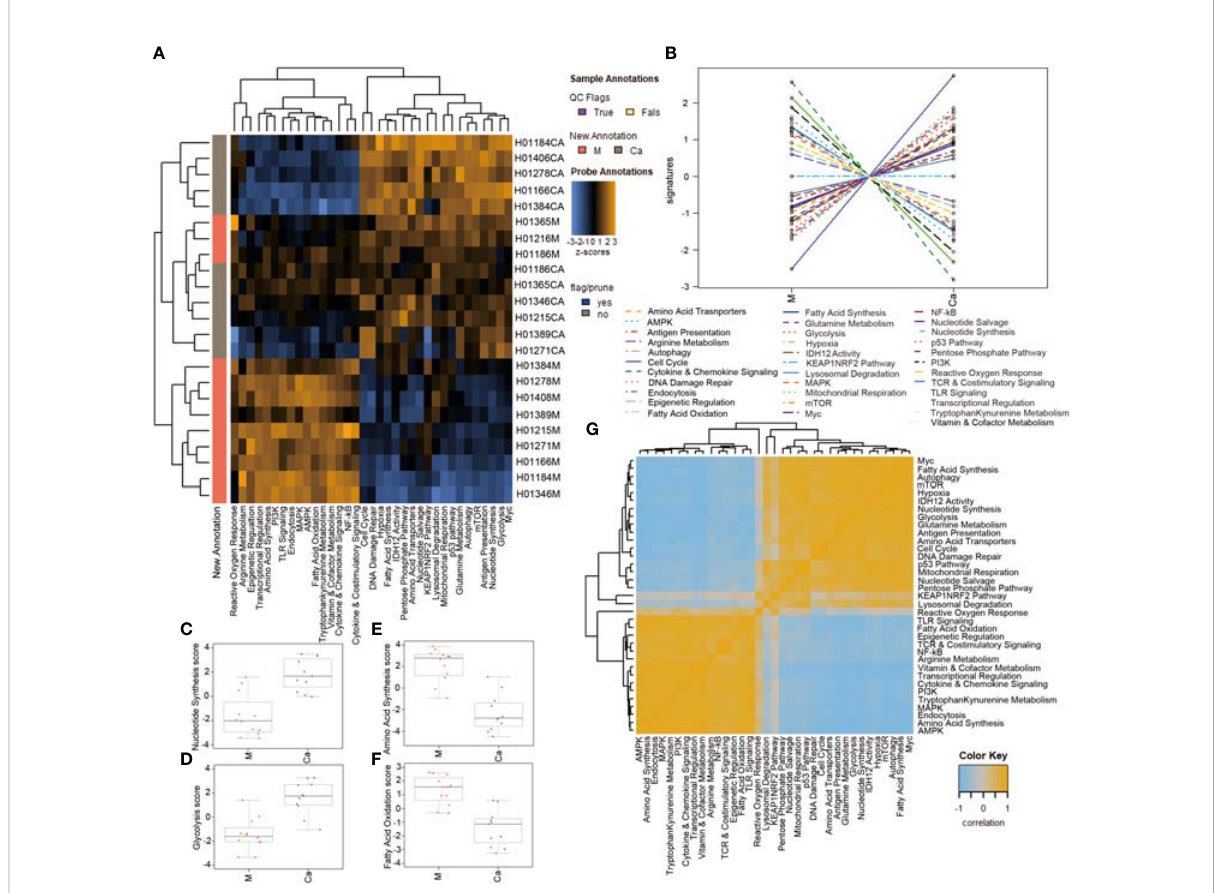
FIGURE 2 Analysis of differential signaling pathways in Metabolic Pathways Panel between HSCC tissues and adjacent normal tissues. (A) Heatmap showing the pathway scores. This plot is a high-level overview of how the pathway scores change across samples. Orange indicates high scores; blue indicates low scores. (B) Heatmap showing the correlation matrix of pathway scores. Orange and blue indicate positive and negative correlation, respectively. (C, D) Pathway scores of signi fi cantly upregulated pathway in HSCC tissues. (E, F) Pathway scores of signi fi cantly downregulated pathways in HSCC tissues. (G) Heatmap of the correlation matrix of pathway scores. Heatmap showing the correlation matrix of pathway scores. Orange and blue indicate positive and negative correlation, respectively. (Ca: HSCC tissues M: Adjacent normal